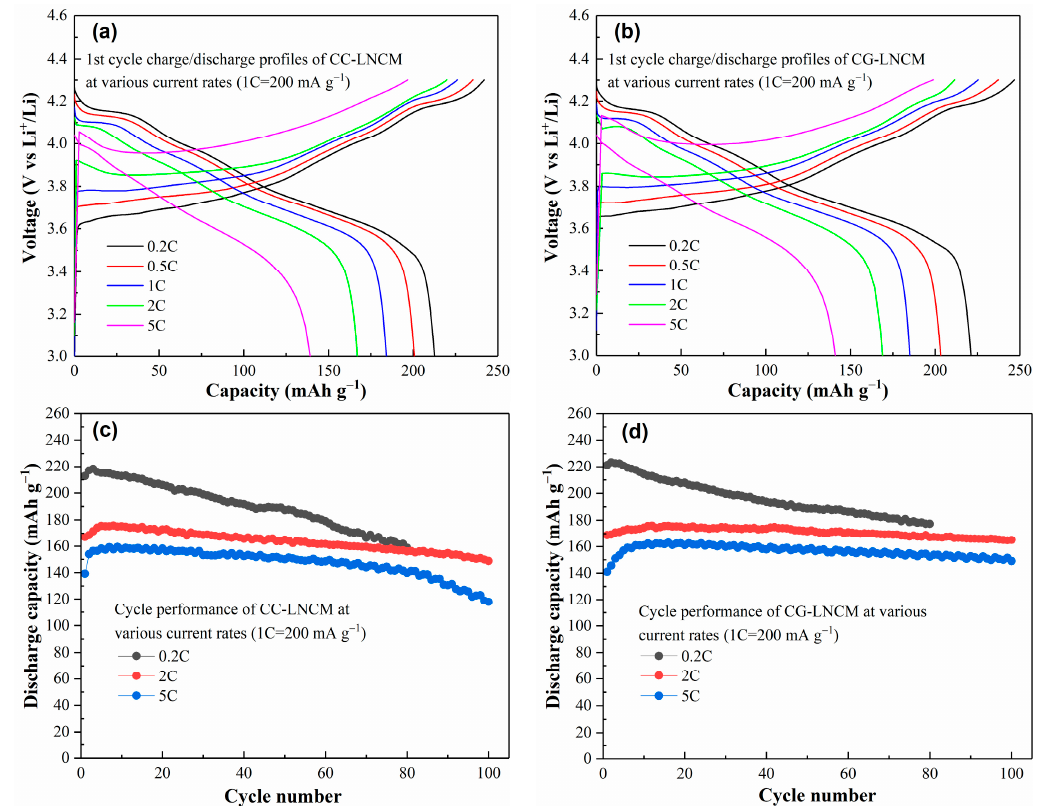
Figure 6. Initial charge/discharge profiles of ( a ) CC-LNCM and ( b ) CG-LNCM at various current rates, cycle performance of ( c ) CC-LNCM and ( d ) CG-LNCM at various current rates. The cycle performance of CC-LNCM and CG-LNCM at 0.2C, 2C and 5C are depicted